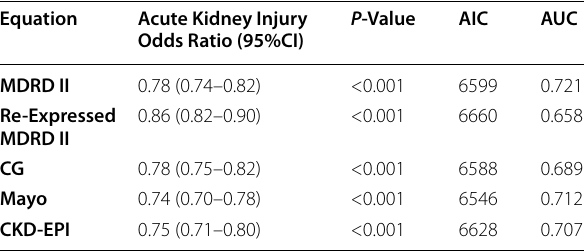
Table 3 Logistic regression analysis of odds of developing AKI by each of the five equations